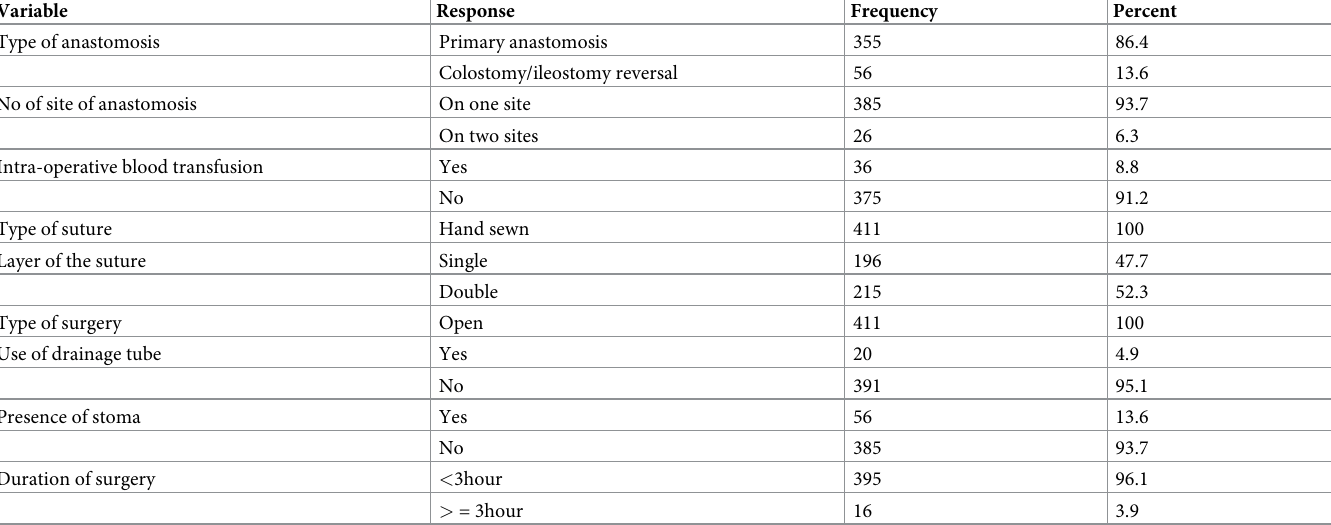
Table 3. Intra-operative status of the patient related characteristics among patients who had intestinal anastomosis surgery in Northwest Amhara regional State referral Hospitals, from February 2017 to February 2020. (n = 411). Variable